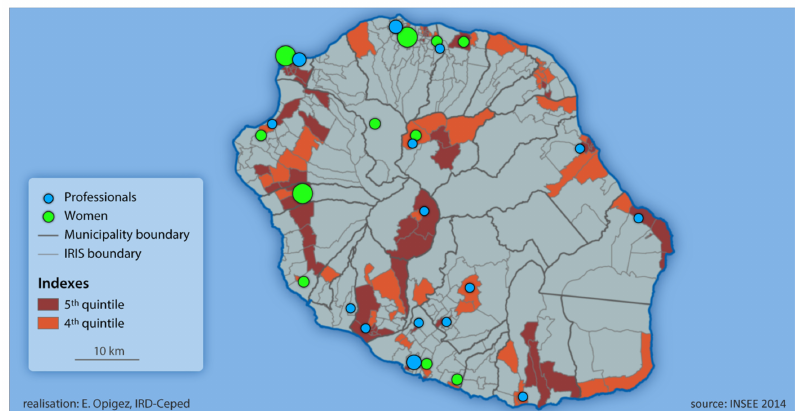
Figure 1. Geographic distribution of study